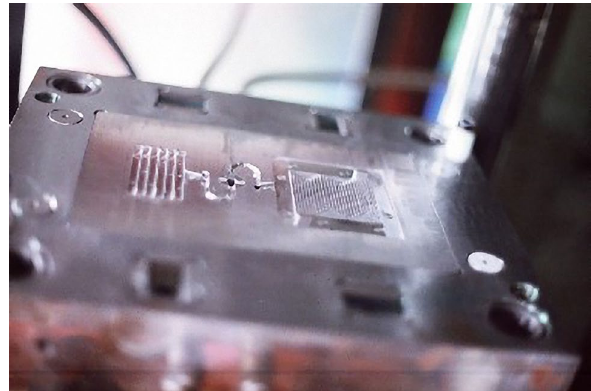
Figure 7. PMMA bipolar plate of Injection mold figure.